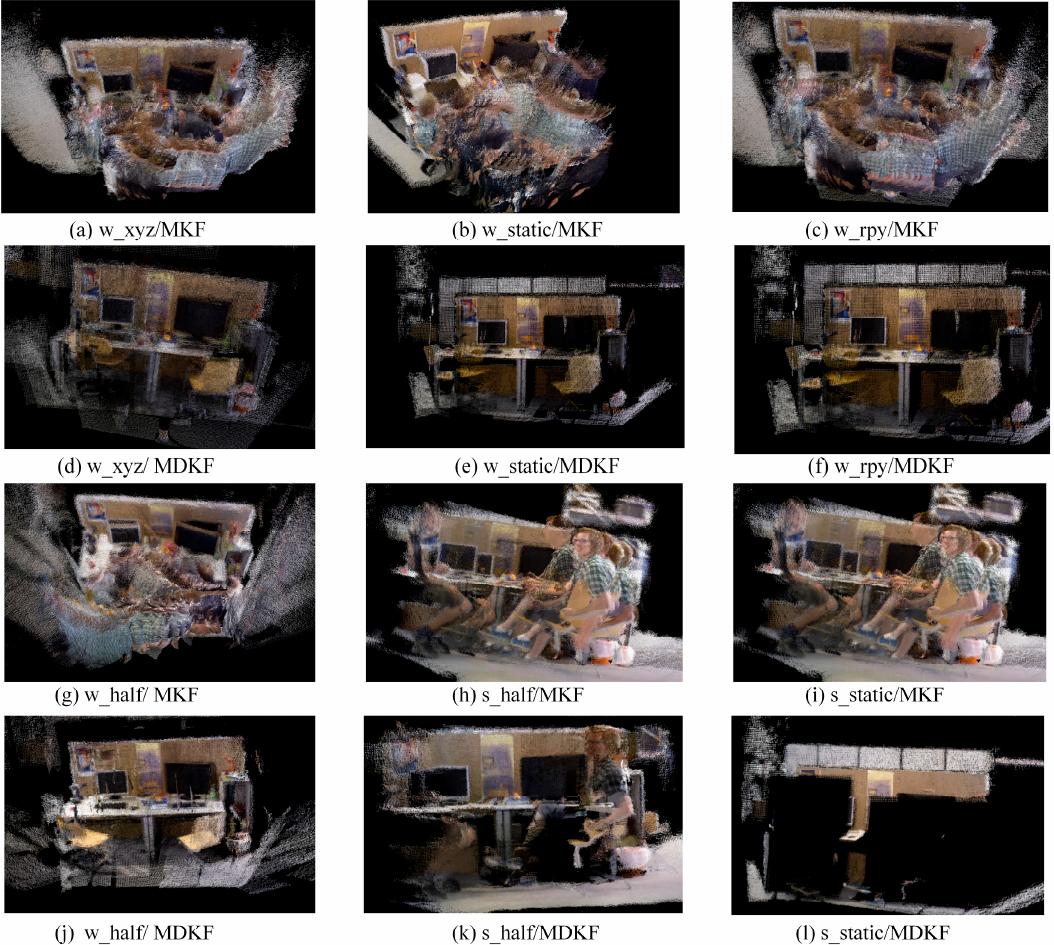
Figure 7. Results of the point cloud map creation. The two map construction strategies were tested on experimental sequences. ( a )–( c ) and ( g )–( i ) are the test results of MKF. Maps built by MDKF and filtered out dynamic objects are shown in ( d )–( f ) and ( j )–( l ).